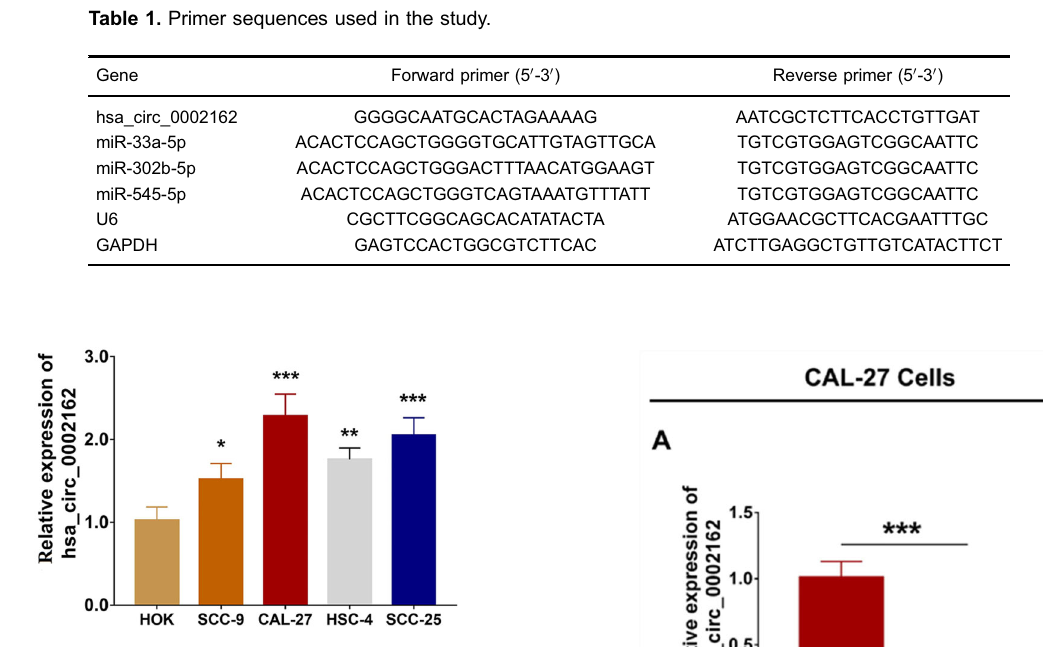
Figure 1. Expression of hsa_circ_0002162 in human tongue squamous cell carcinoma cell lines and human oral keratinocytes (HOK). Data are reported as means ± SD. *P o 0.05, **P o 0.01, ***P o 0.001 compared to HOK (ANOVA). Table 1. Glyceraldehyde-phosphate dehydrogenase (GA PDH) was used as internal reference of circRNA, and U6 was used as internal reference of miRNA. Relative quanti fi cation of gene expression was performed by the 2 – WW Ct method.